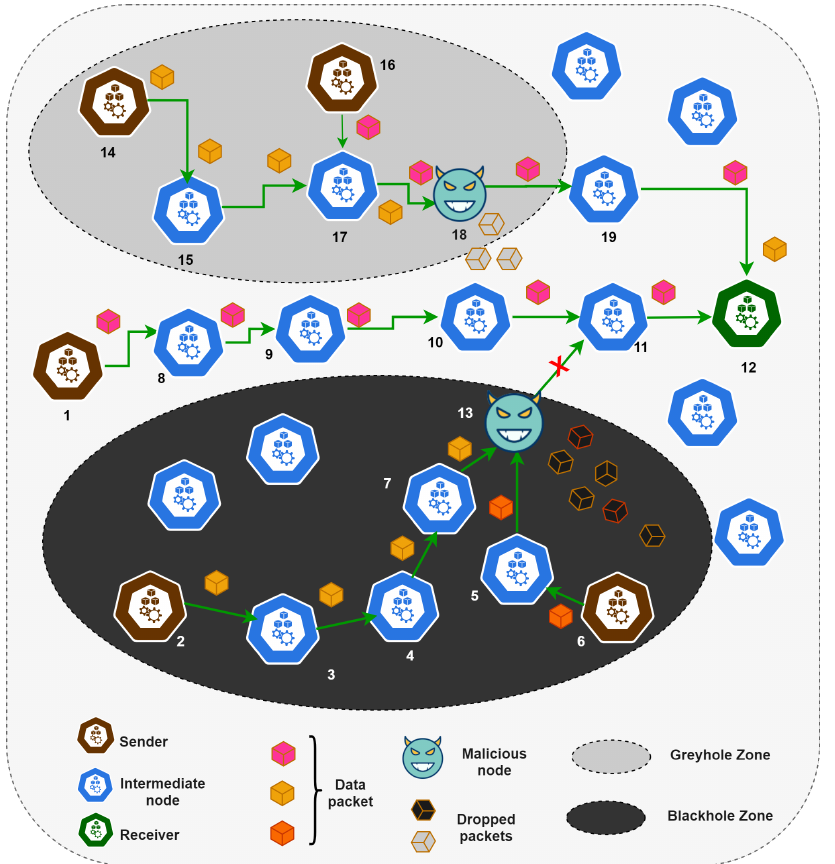
Figure 1. Blackhole and greyhole attack